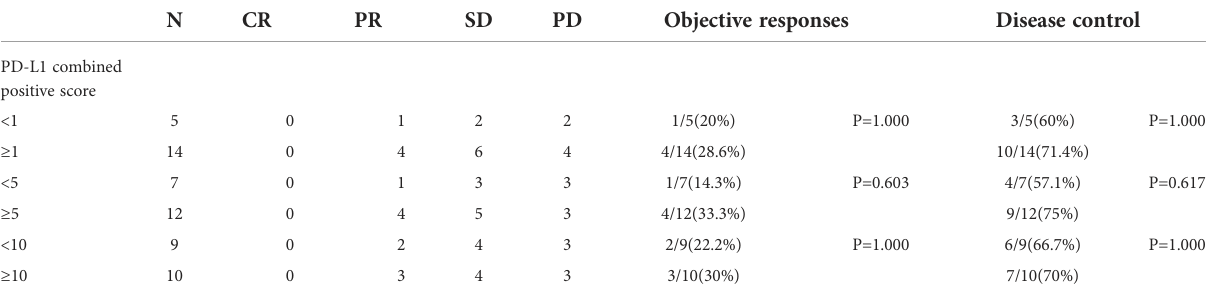
TABLE 6 Responses by PD-L1